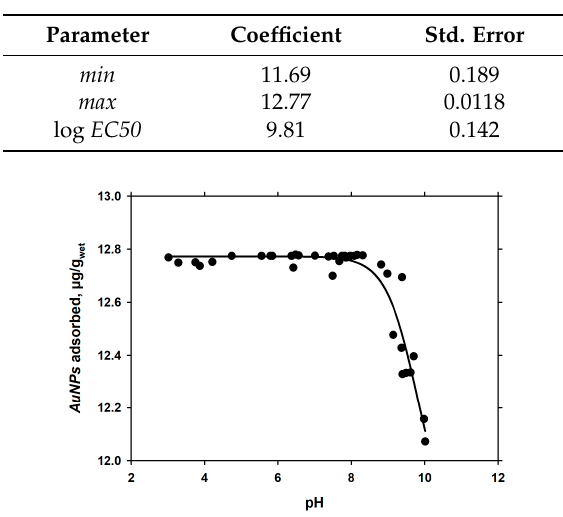
Figure 5. pH-dependence of AuNPs adsorption on the surface of diatoms EOMI (10 g wet /L, 130 µg/L AuNPs , 2 h of reaction) and a one-site competition fit to the data.